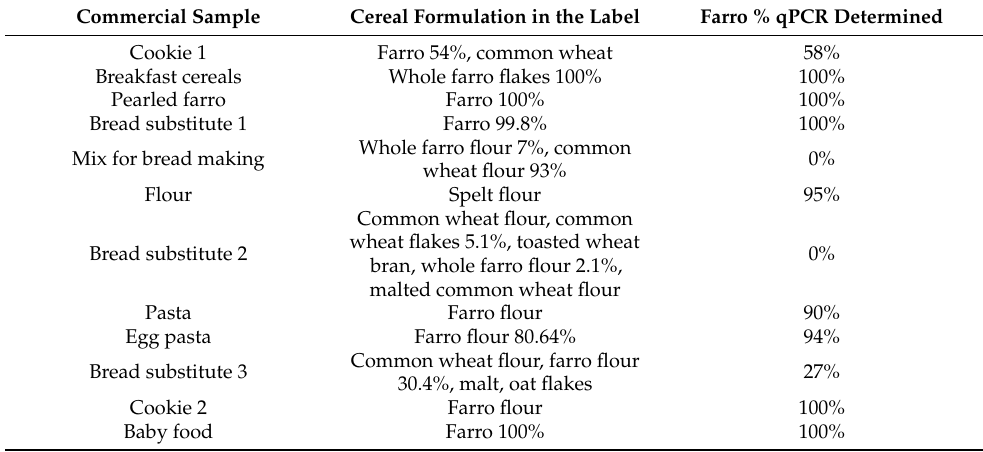
Table 6. Commercially available food sampled, their cereal content as reported in the label and hulled wheat percentages determined using a qPCR